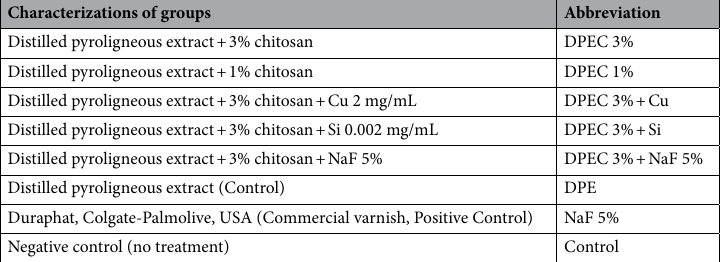
Table 2. Description of films by chitosan containing pyroligneous extract in each group